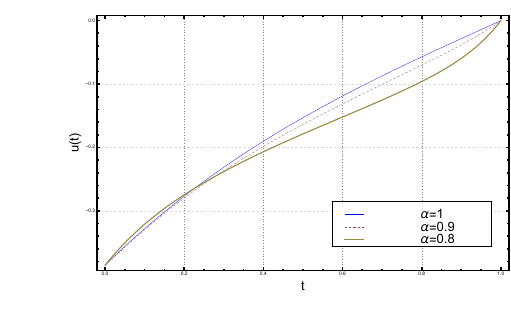
Figure 1. Different solutions of Example 3.